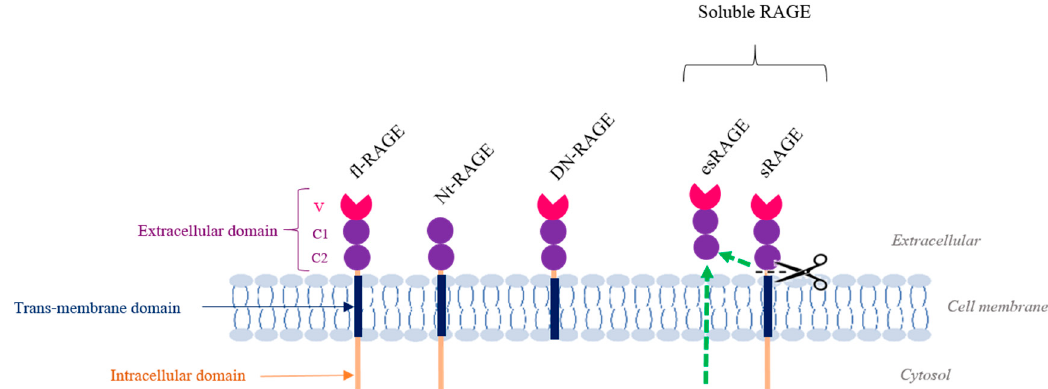
Figure 3. RAGE and its isoforms. This figure illustrates the different protein isoforms of RAGE. Only the full-length (fl-RAGE) version can exercise a complete signal transduction by first interacting with ligands with its extracellular domain (V: variable; C: constant) similar to immunoglobulins and then recruiting protein adaptors using its intracellular domain. Other isoforms, especially soluble ones (esRAGE, directly translated from a transcript and sRAGE, resulting from an enzymatic cleavage of fl-RAGE), are implicated in the negative feedback of RAGE activity by competition. Finally, Nt-RAGE and DN-RAGE have also been briefly described in the literature.